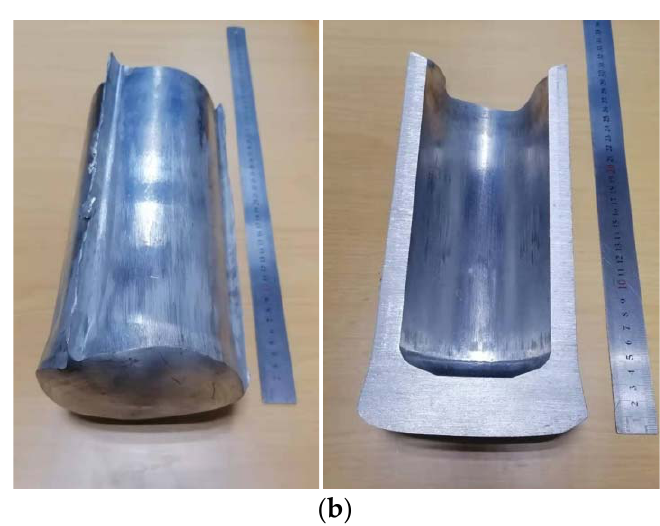
Figure 17. Roll-formed cups: ( a ) bottom thickness of 20 mm; ( b ) 30 mm.